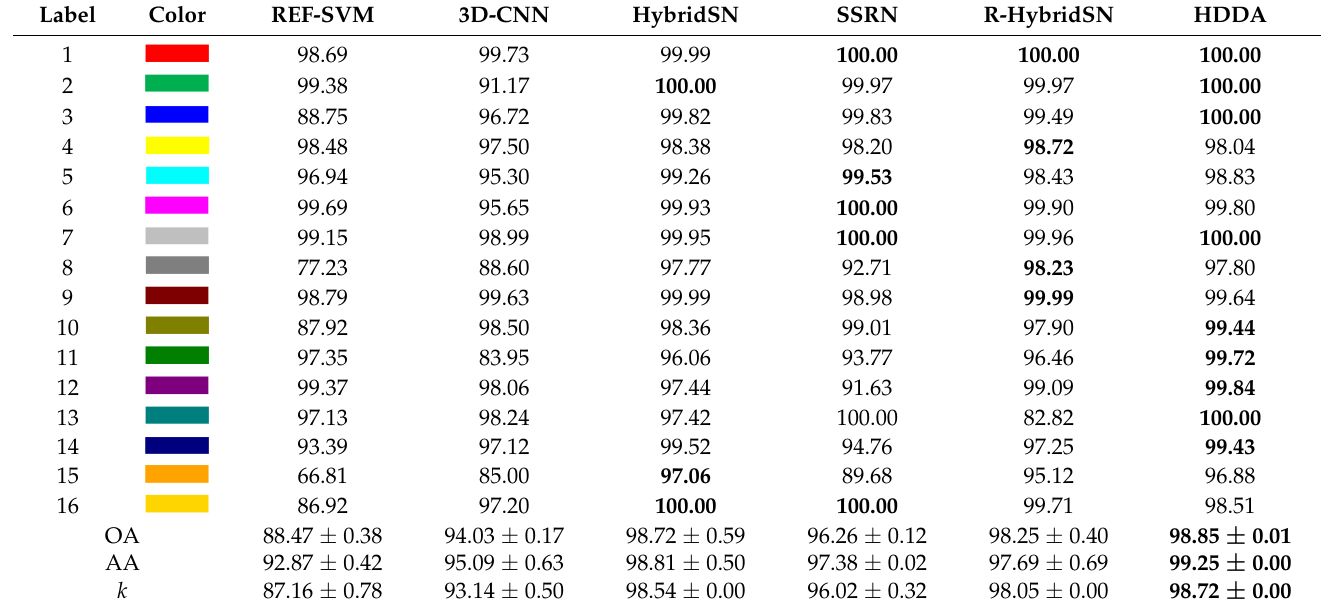
Table 10. Comparison of accuracy using the HDDA and five other methods for the SA